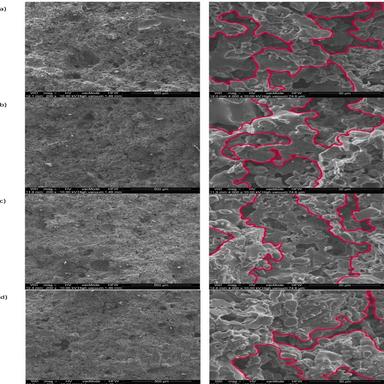
SEM micrographs of the obtained ceramsites at magnification of 200× and 4000× for: a) CER-1; b) CER-2, c) CER-3; d) CER-4.